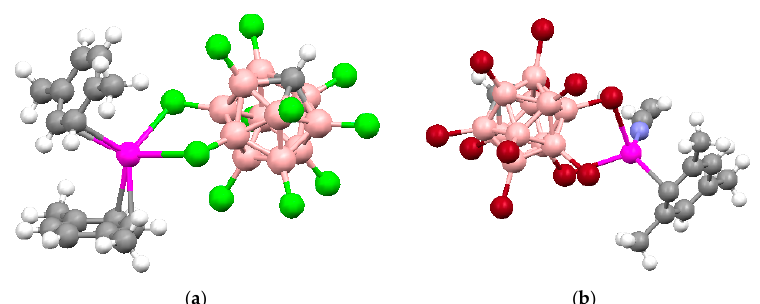
( a ) ( b ) Figure 72. X-ray structures of {( η 2 - p -xylene) 2 Ag[1-HCB 11 Cl 11 ]} ( a ) and {( η 1 -mesitylene)(MeCN) Ag[1-HCB 11 Br 11 ]} ( b ).